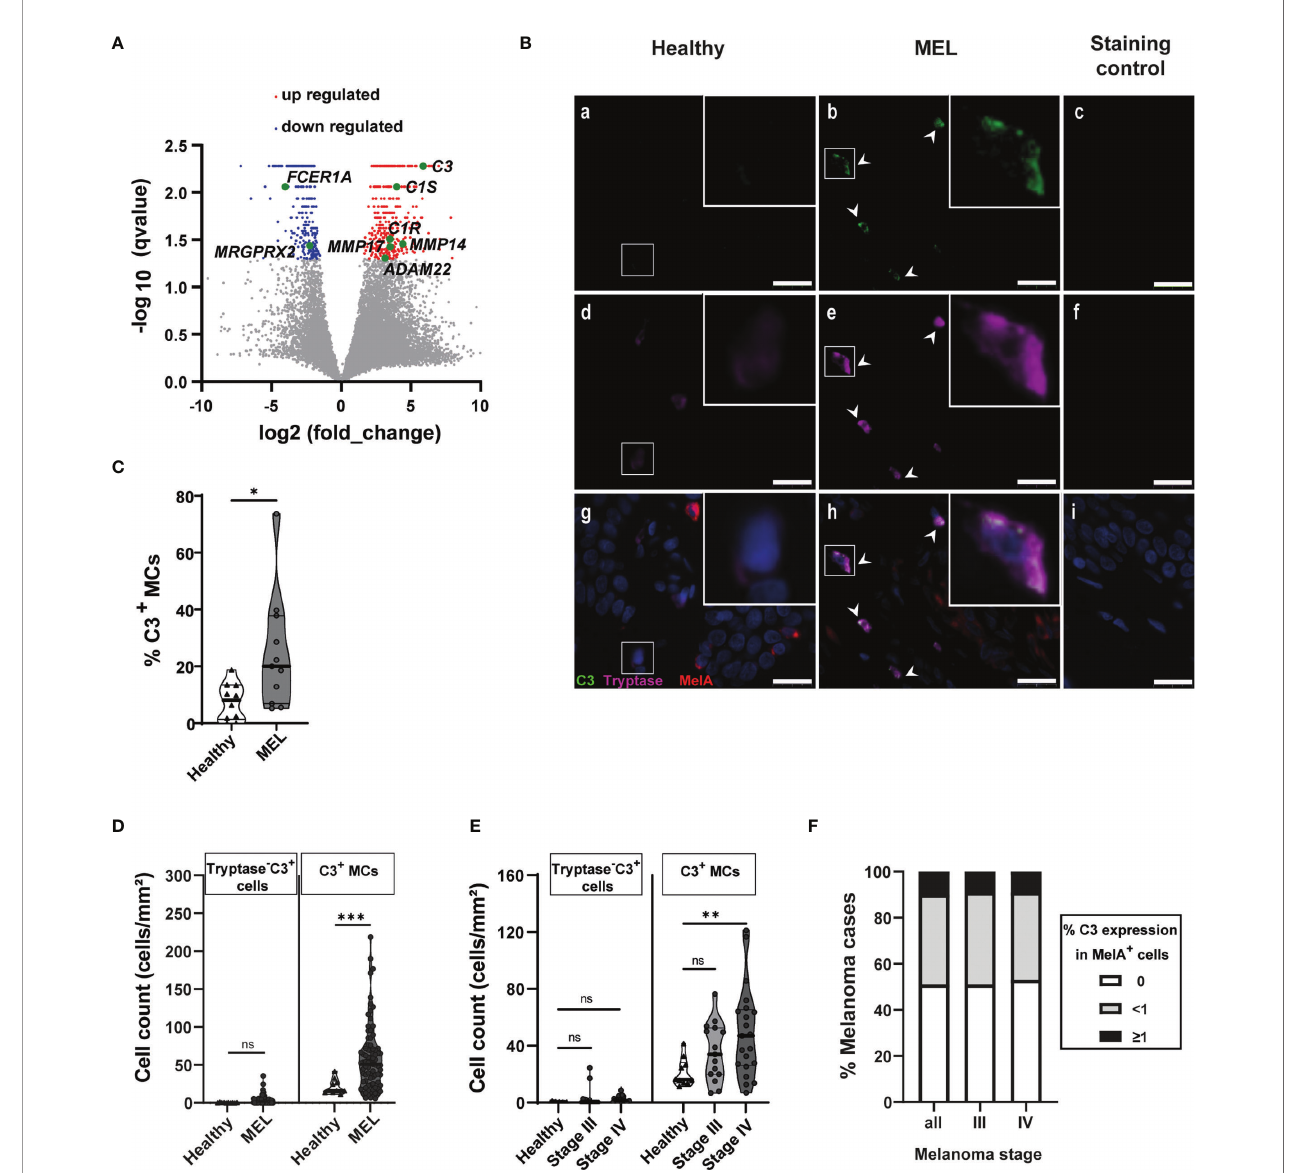
FIGURE 3 | Melanoma-associated mast cells express C3. (A) Volcano plots display differential gene expression between MAMCs and HSMCs. Each gene is symbolized by a dot: red dots indicate signi fi cantly upregulated genes and blue dots indicate signi fi cantly downregulated genes in MAMCs. (B) Stain of fi xed healthy (Healthy) and melanoma (MEL) skin biopsies. Representative images of immuno fl uorescence staining of tryptase (magenta) and co-expressed complement 3 (C3) (green) in MAMCs (b, e, h) compared with HSMCs (a, d, g). Control: no primary antibody added (c, f, i). Nuclear staining was performed with DAPI (blue). Scale bars represent 20 m m. White arrows show the C3 + MCs. White squares mark the areas shown at a higher zoom in the upper right. Tryptase + and tryptase + C3 + MCs were counted. (C) Violin plots show the calculated percentage of tryptase + C3 + MCs in healthy ( n = 10) and MEL skin biopsies ( n = 11). Data are displayed as median (heavy line) with interquartile range. Statistical comparisons were performed using Mann – Whitney U -test. * p = 0.0155. (D) Violin plots display C3 + tryptase − and C3 + tryptase + (C3 + MCs) cell numbers in healthy skin samples (healthy, n = 10) and in melanoma borders (MEL, n = 82). Results are shown as mean with quartile range. Statistical comparisons between healthy and MEL cell counts were performed using Mann – Whitney U -test, *** p < 0.001, ns = not signi fi cant. (E) Violin chart comparing C3 + tryptase − and C3 + tryptase + (C3 + MCs) cell numbers in healthy skin ( n = 10) and melanoma at stage III ( n = 15) and stage IV ( n = 20). Data are displayed as median with interquartile range. One-way ANOVA statistical test was used, ** p < 0.01, ns = not signi fi cant. (F) C3 and MelA immunohistochemistry staining was performed on 93 biopsies located in the central melanoma area, and MelA + and C3 + cells were counted. C3 expression levels were de fi ned as three groups: 0, no C3 expression (white bars); <1, less than 1% of C3 + MelA + cells (gray bars); and ≤ 1, equal or greater than 1% of C3 + MelA + cells (black bars). Chart shows the percentage of C3 + MelA + cells in all melanoma biopsies analyzed (total, n = 93), stage III melanoma (stage III, n = 24), and stage IV melanoma (stage IV, n = 31). The polyclonal chicken antibody from Abcam, #ab48580, was used for C3/C3a staining in (B , D – F ), and in (C) , the polyclonal chicken antibody from Sigma, #GW20073F, was used for C3